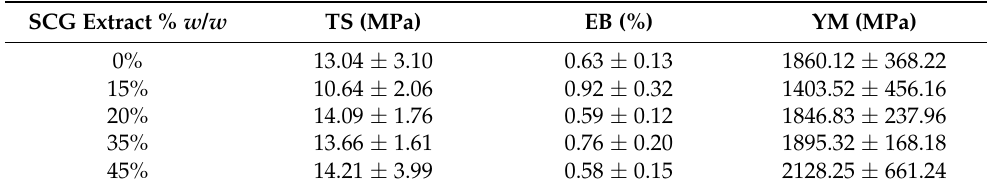
Table 3. Mechanical properties of zein samples produced by solvent casting in terms of tensile strength (TS), elongation at break (EB), and Young’s modulus (YM)